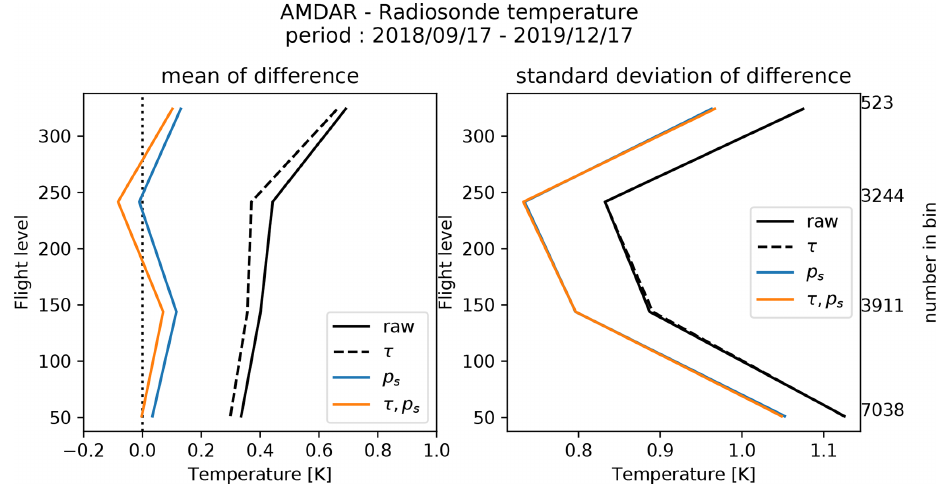
Figure 2. Statistics of AMDAR temperature minus radiosonde temperature.